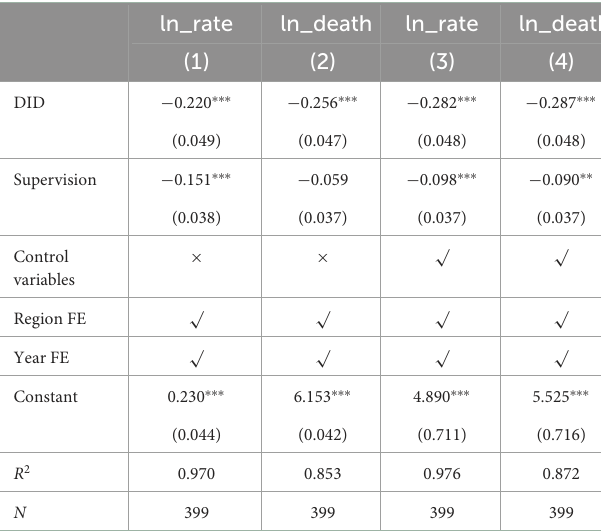
TABLE 5 Results of controlling other policy effects.